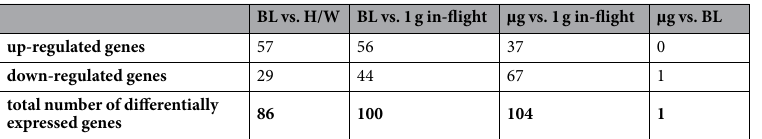
Table 7. Differentially expressed annotated genes in T cells during the TEXUS-51 mission. Number of annotated significantly differentially expressed genes in the respective comparison after elimination of differentially expressed genes due to hardware effects (hardware 1 g ground control compared to the cell culture control) and 1 g in-flight effects (1 g in-flight control compared to the hardware 1 g ground control). H/W: hardware 1 g ground control samples, BL: baseline control samples representing the influence of the rocket launch, µ g: microgravity samples. Fold change ± 1.3, p < 0.05.